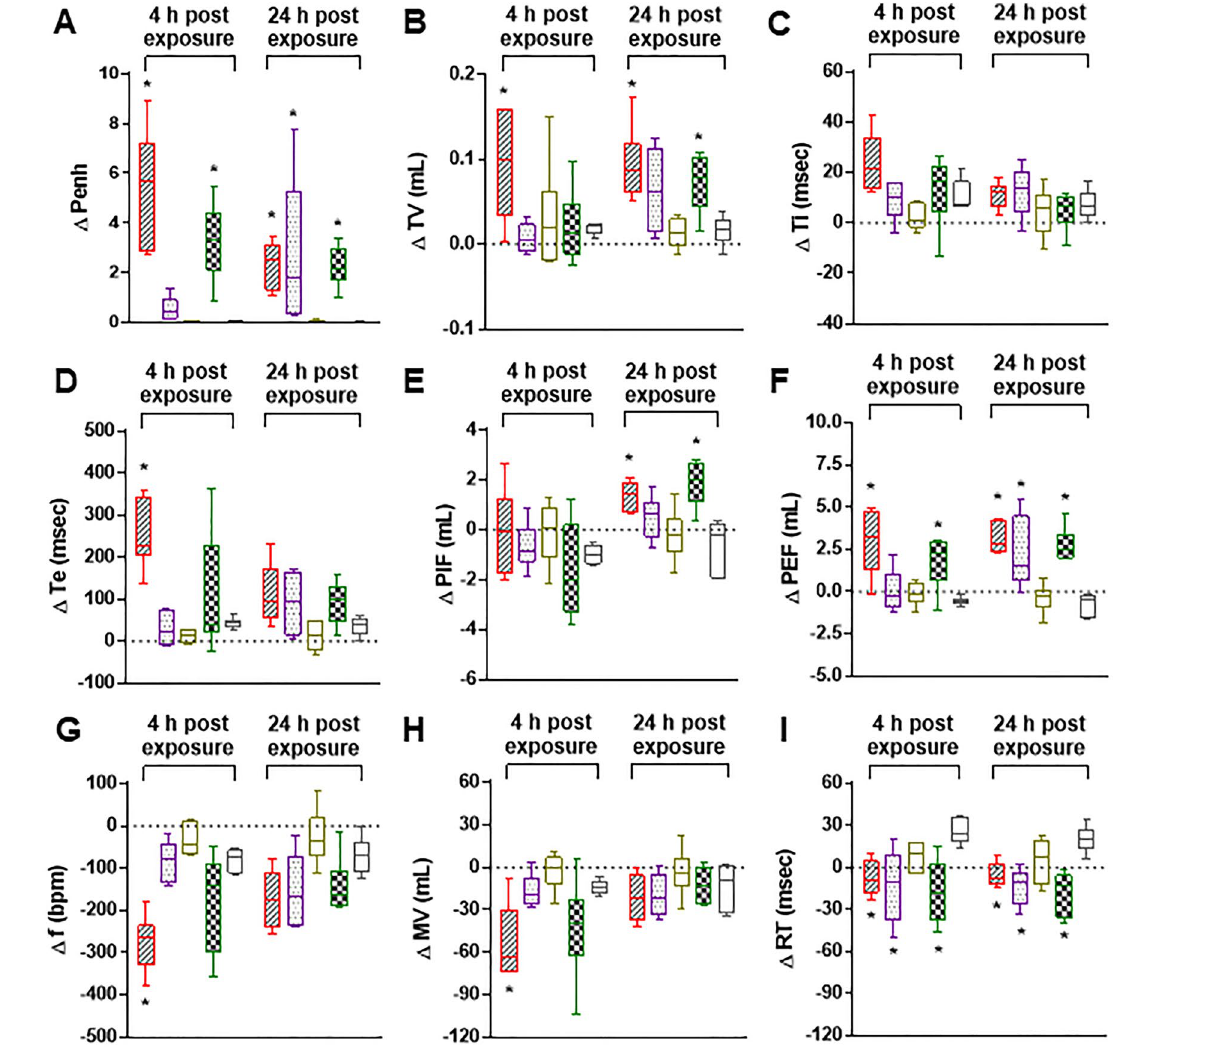
Figure 7. Lung function of mice exposed to the rifle smoke PM, water-soluble components, water-soluble components without metal ions (low-metal), and water-insoluble components. ( A ) Penh, ( B ) Tidal volume (TV), ( C ) Inspiratory time (Ti), ( D ) Expiratory time (Te), ( E ) Peak inspiratory flow (PIF), ( F ) Peak expiratory flow (PEF), ( G ) Breathing frequency (f), ( H ) Minute ventilation (MV), ( I ) Relaxation time (RT). Mice were exposed to the PM (20 µg) by oropharyngeal aspiration and BALF was obtained at 4 and 24 h post exposure. Data are mean ± SEM obtained from 6 mice for each group. * p < 0.05 compared with the pre-exposed (baseline) group from the same time point (one-way ANOVA with post-hoc Dunnett’s